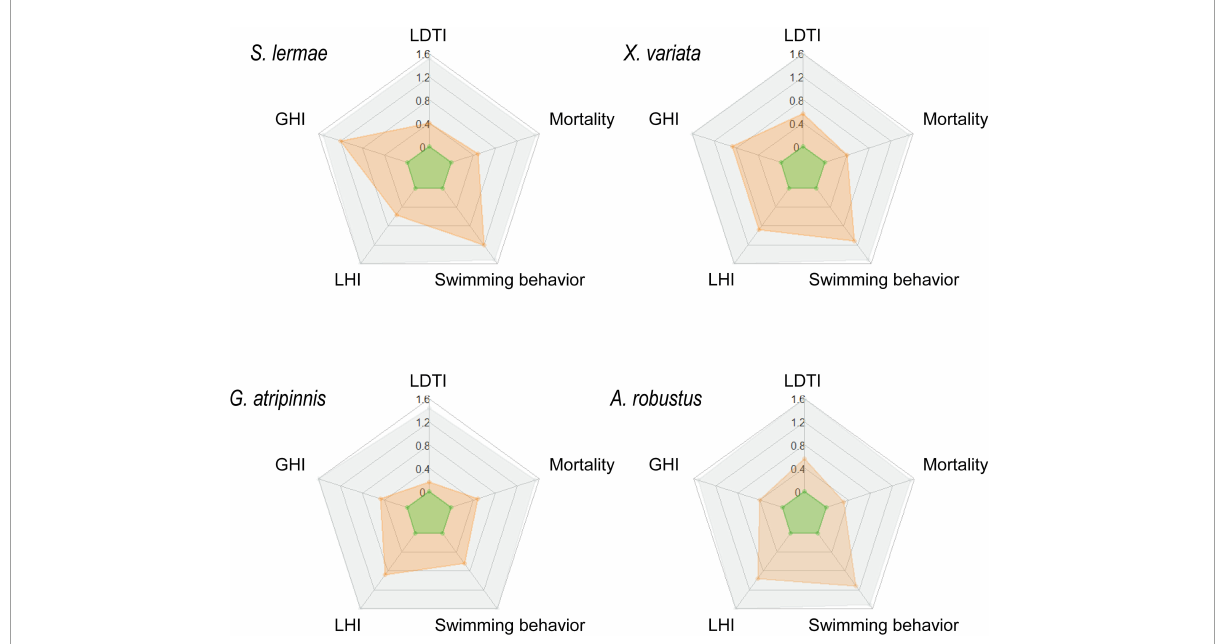
FIGURE5 Integrated biomarker response (IBR) for four goodeine species exposed to NaNO 3 -N. Radar graphs show the calculated IBR for S. lermae , X. variata , G. atripinnis, and A. robustus from the control condition (green), exposed to the concentration closest to the LC 50 (orange) and LC 100 (gray). The spokes of the radar indicate all traits evaluated: mortality and swimming behavior, as well as gill (GHI), liver histopathological (LHI), and tissue damage indexes